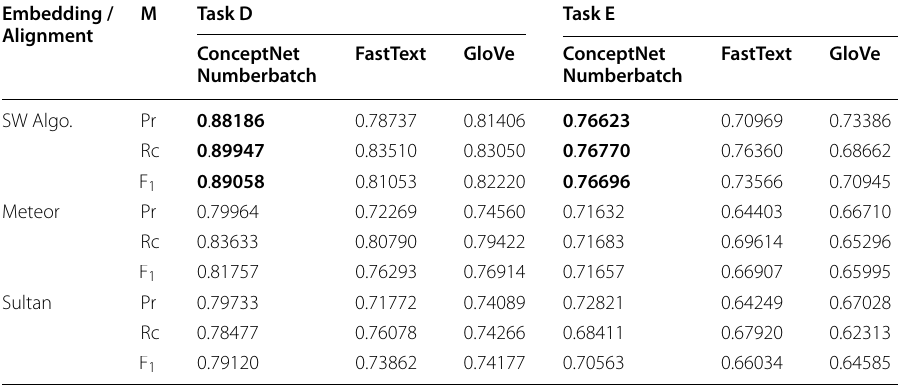
Bold values refer to the highest values of F 1 scores of each task